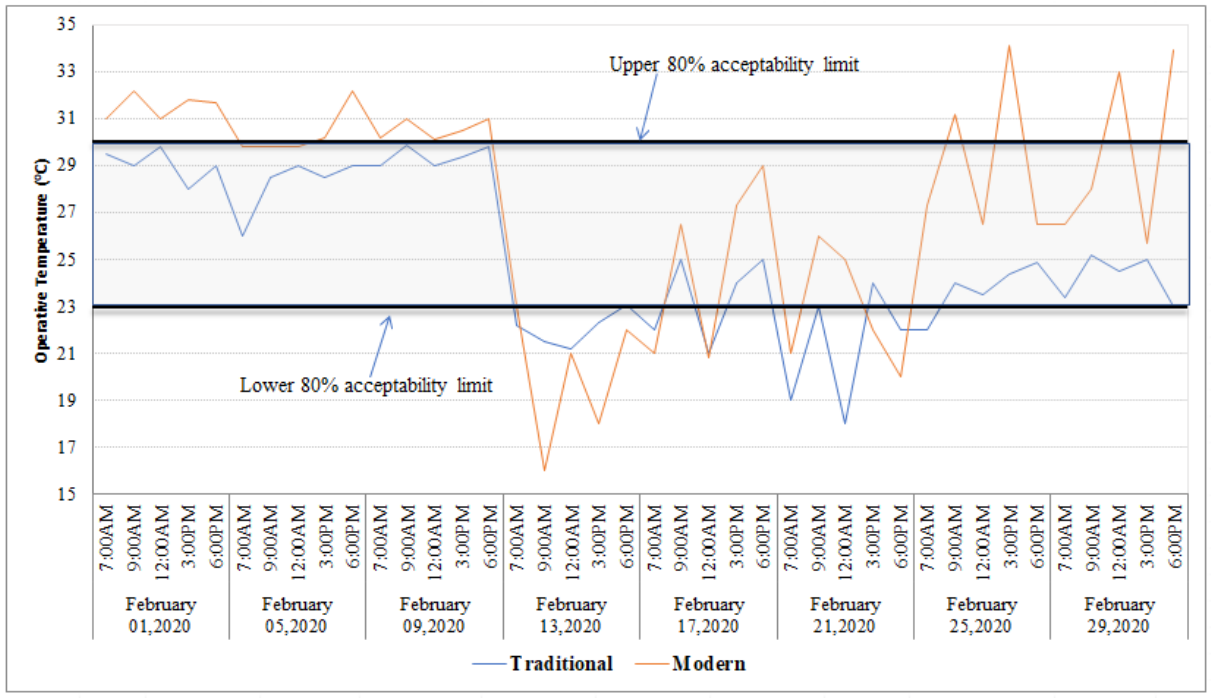
Figure 22. Indoor thermal comfort evaluation from February 2020.